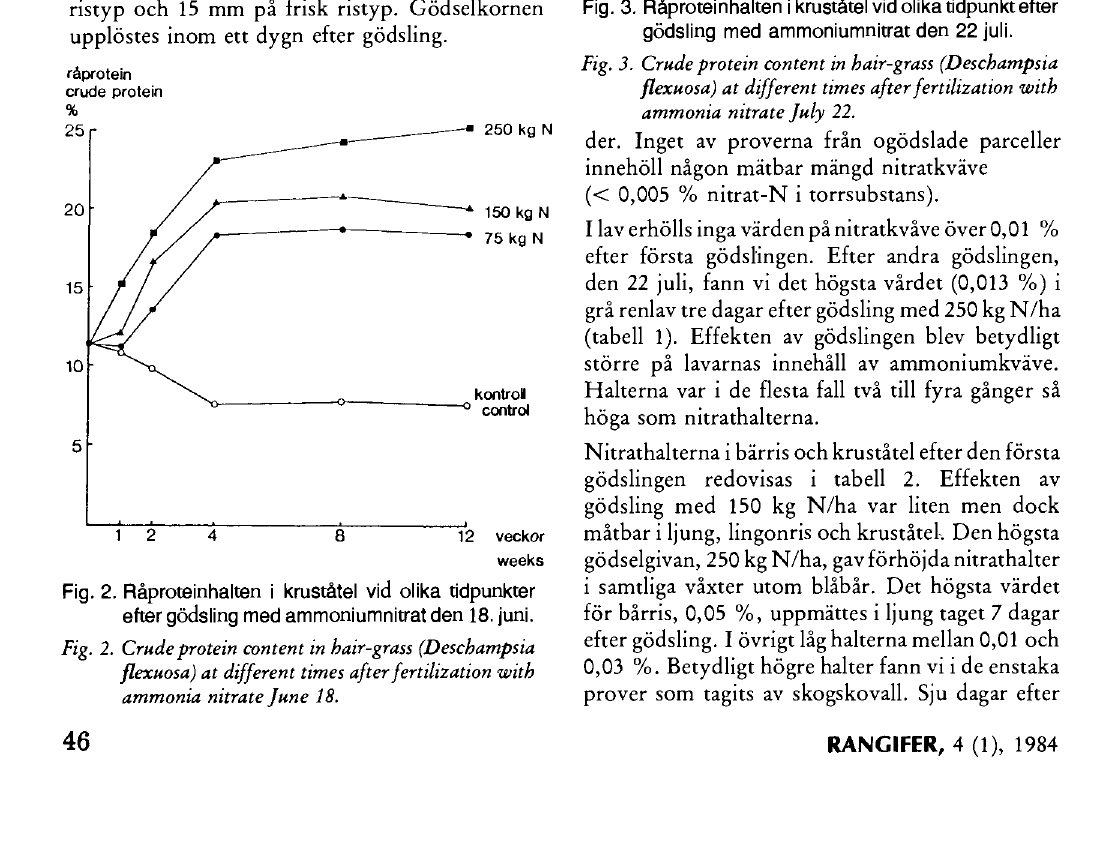
Fig. 2. Raproteinhalten i krustatel vid olika tidpunkter efter godsling med ammoniumnitrat den 18. juni. Fig. 2. Crude protein content in hair-grass (Deschampsia flexuosa) at different times after fertilization with ammonia nitrate June 18.